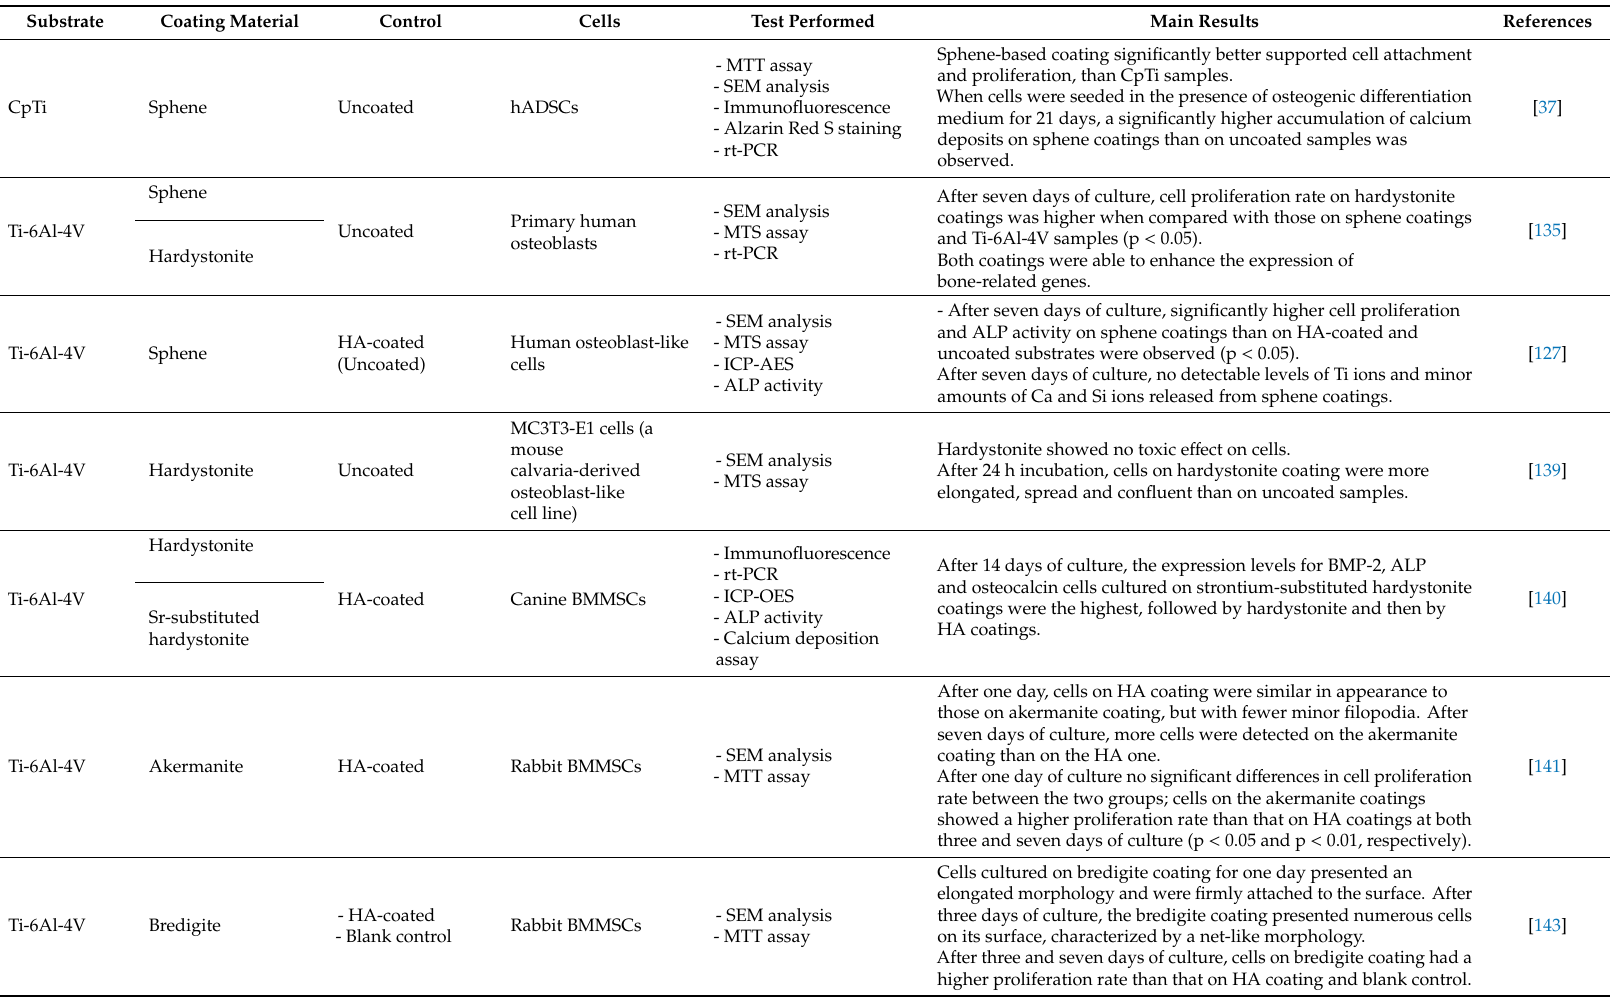
Table 7. Bioactive coatings: in vitro